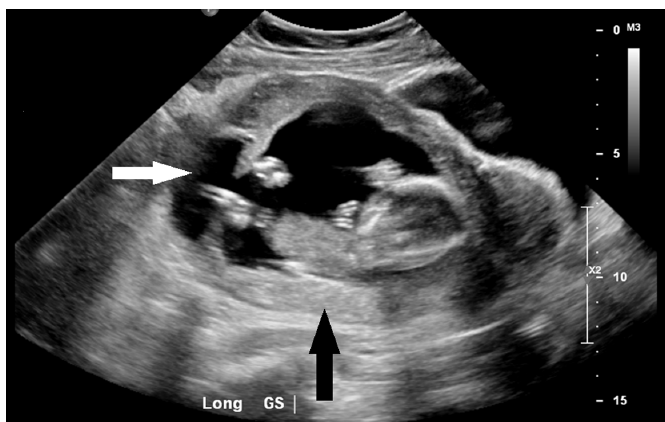
Image 1. Longitudinal image of the gestational sac (GS) depicted by the black arrow. A communication between the gestational sac and peritoneum is depicted by the white